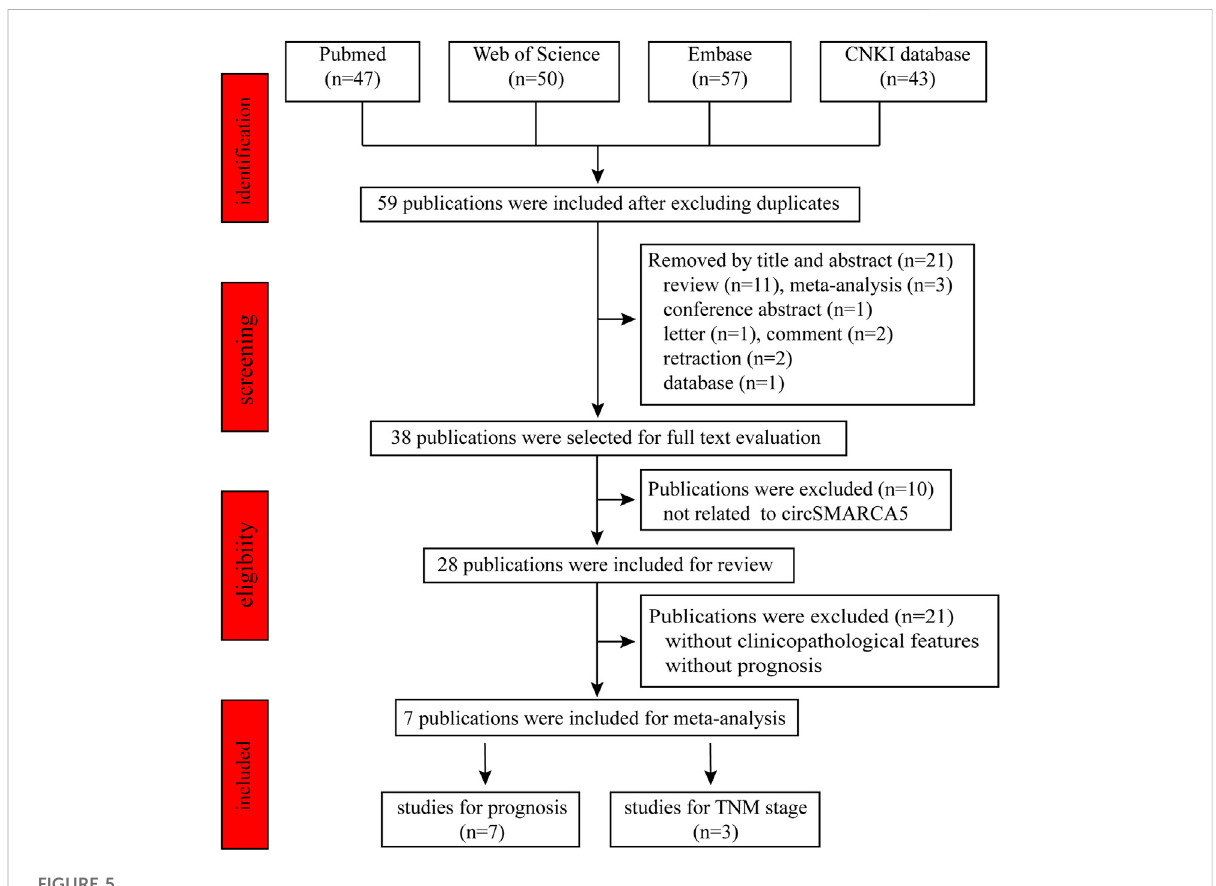
FIGURE 5 A fl ow chart of screening eligible articles for